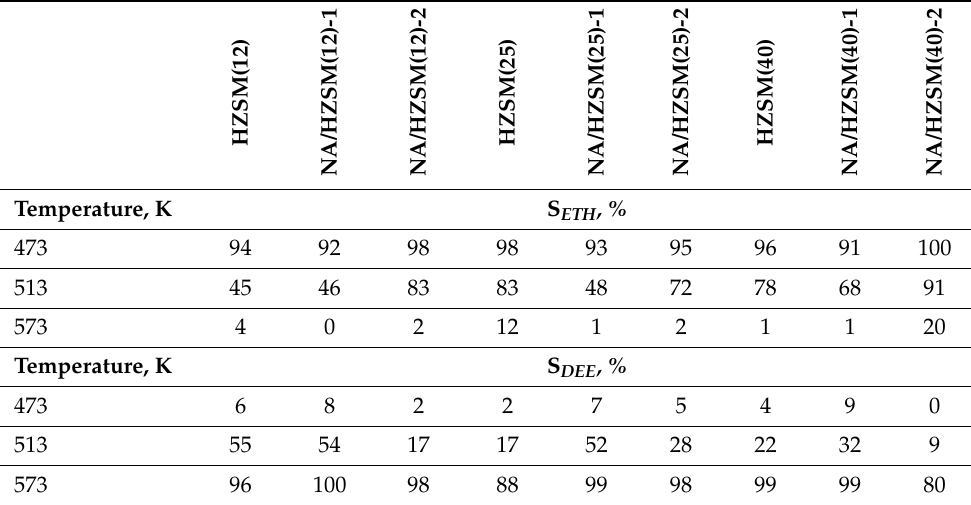
Table 10. Selectivity of ethanol conversion to ethylene (S ETH , % ) and diethyl ether (S DEE , % ) for HZSM, NA/HZSM-1, and NA/HZSM-2 (data from [16]).